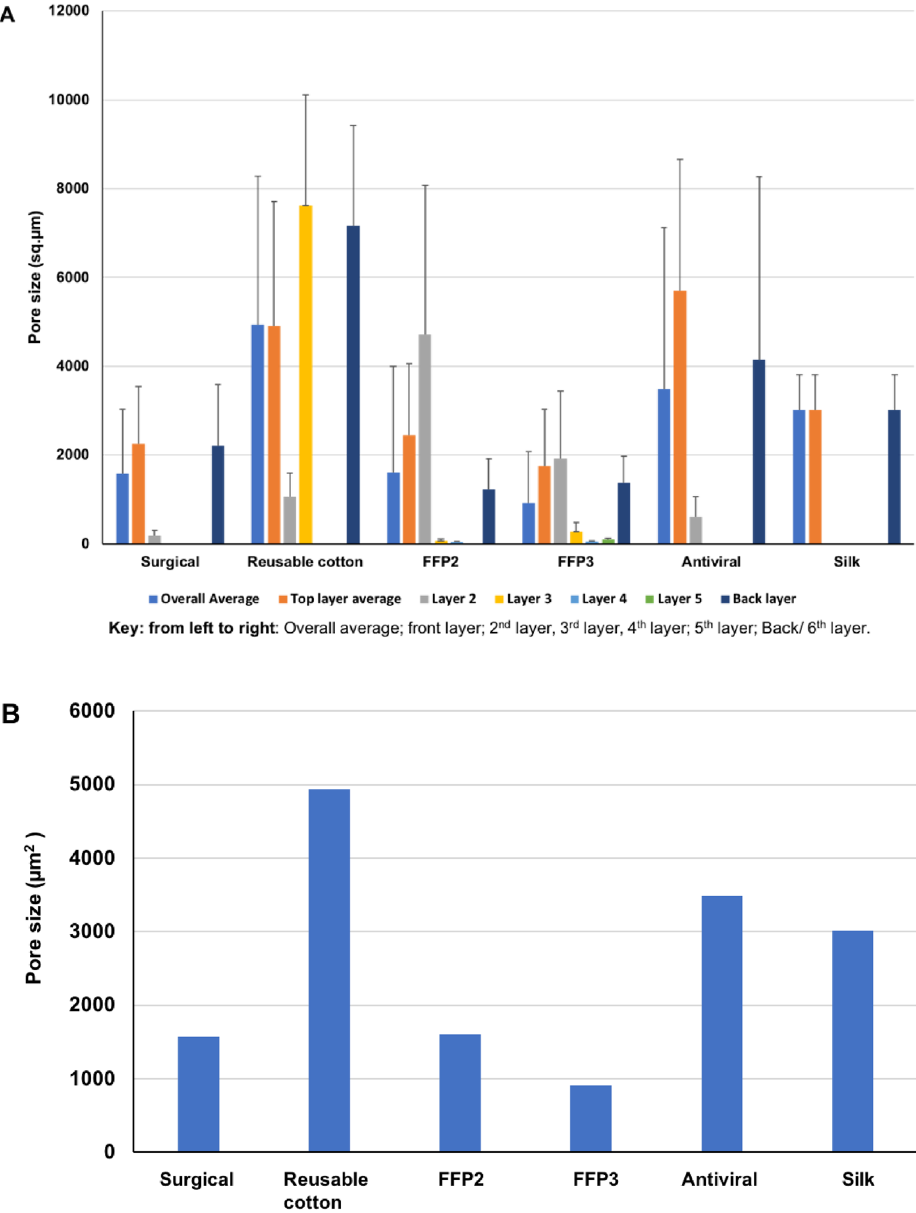
Figure 8. The pore size for the six masks was derived from individual layer measurements. ( A ) for each layer. ( B ) average pore size of each